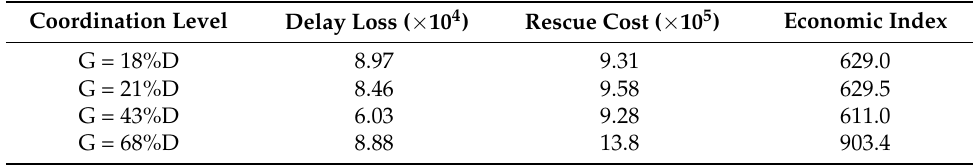
Figure 15. Coordination level. Table 6. Program benefits under the coordination levels. Table 6. Program benefits under the coordination